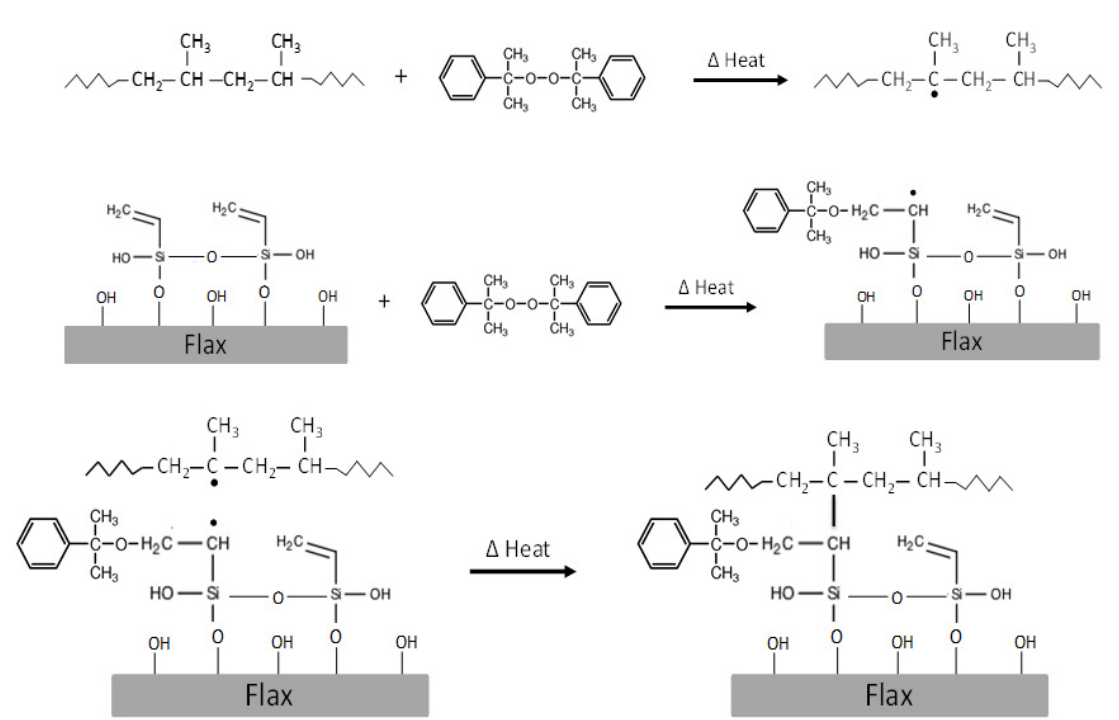
Scheme 3. The formation of siloxane bridge between VTS treated flax and PP